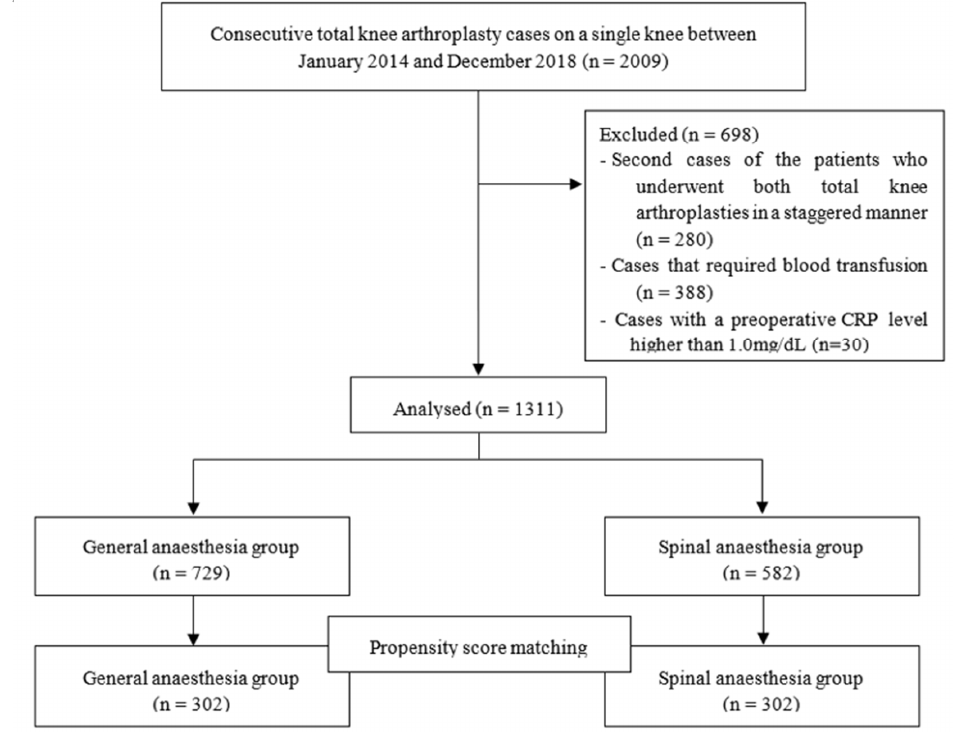
Figure 1. Flow diagram of this study.